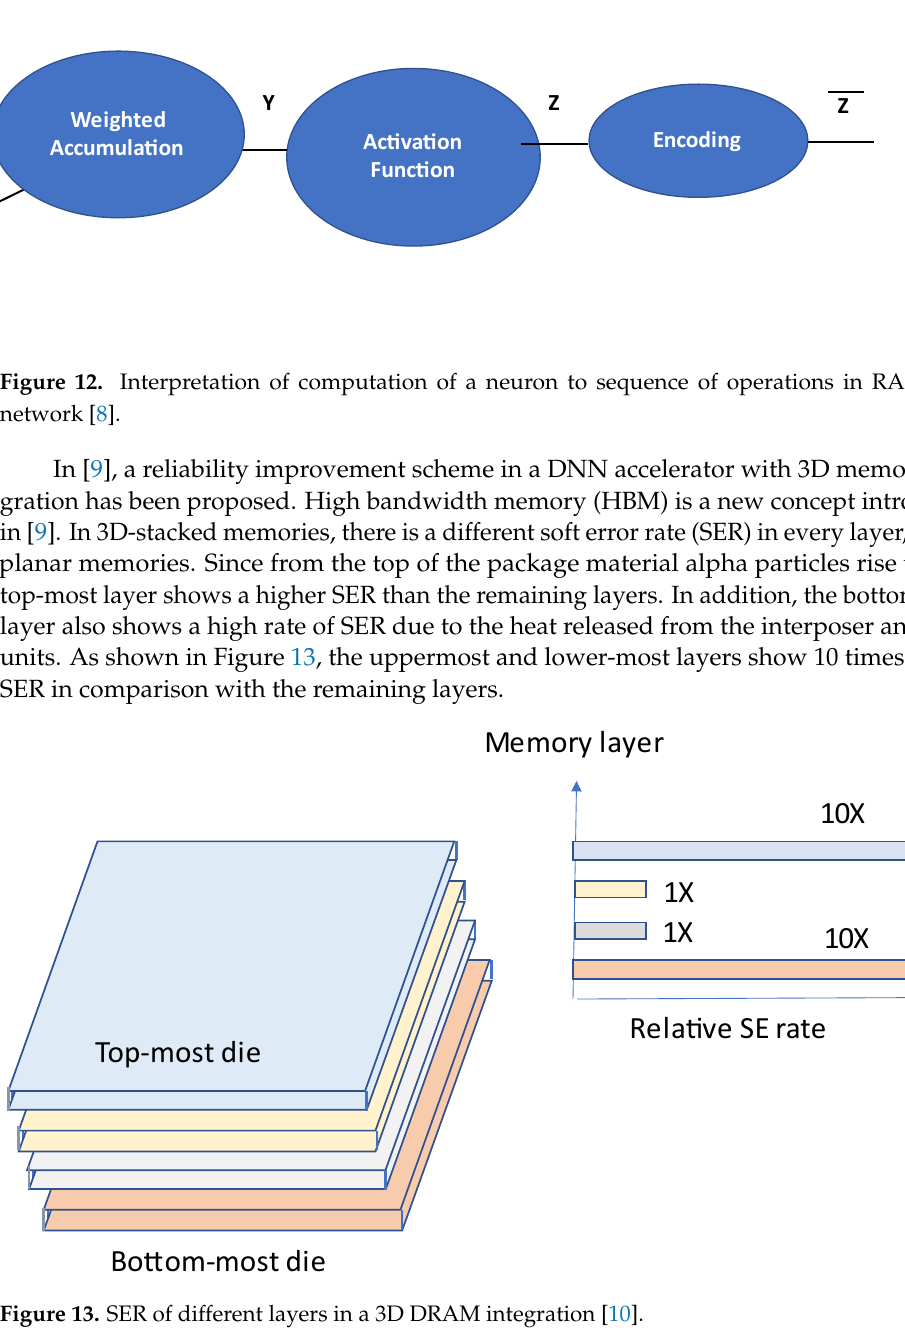
Figure 12. Interpretation of computation of a neuron to sequence of operations in RAPIDNN net- work [8].